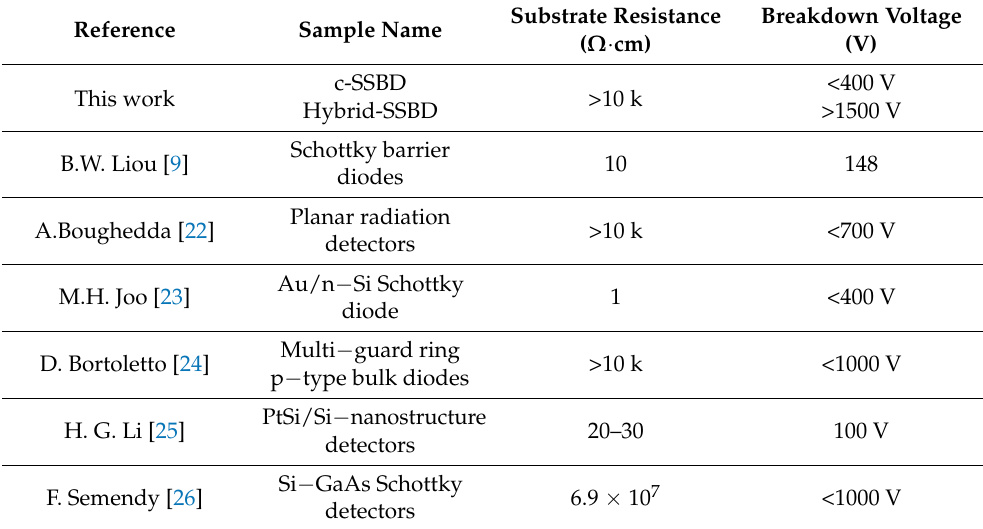
Table 1. Summary and comparison of surface barrier detector